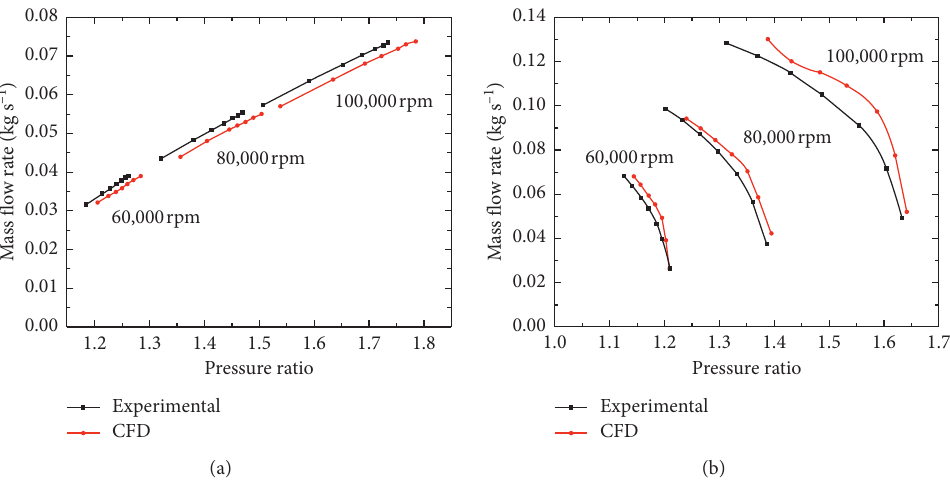
Figure 12: Numerical simulation verified by experiments. (a) Turbine side. (b) Compressor